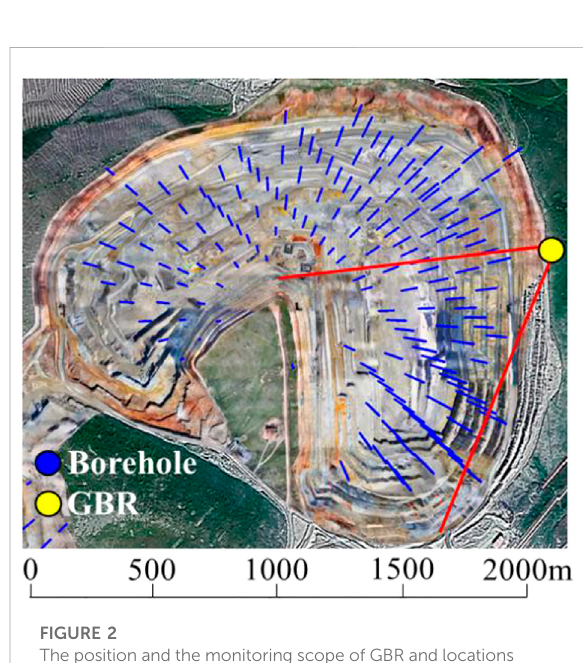
FIGURE 2 The position and the monitoring scope of GBR and locations of the